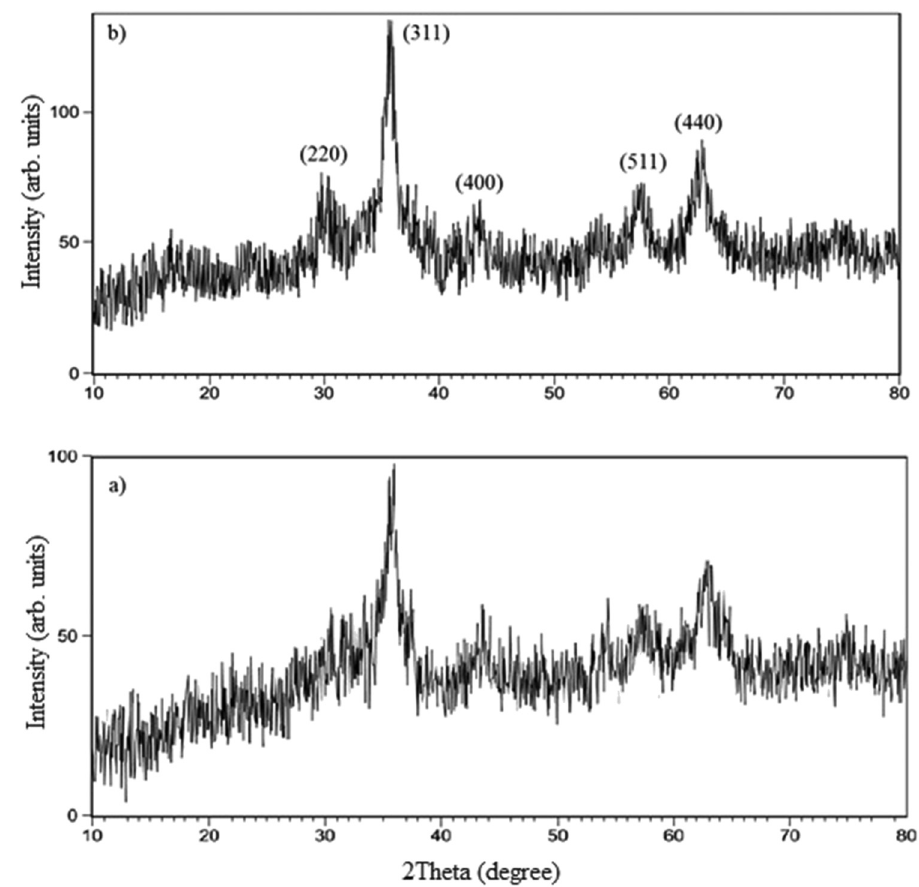
Figure 1: XRD spectrum of CFN after calcination at 500°C for 4 h ( a ) and 8 h ( b )